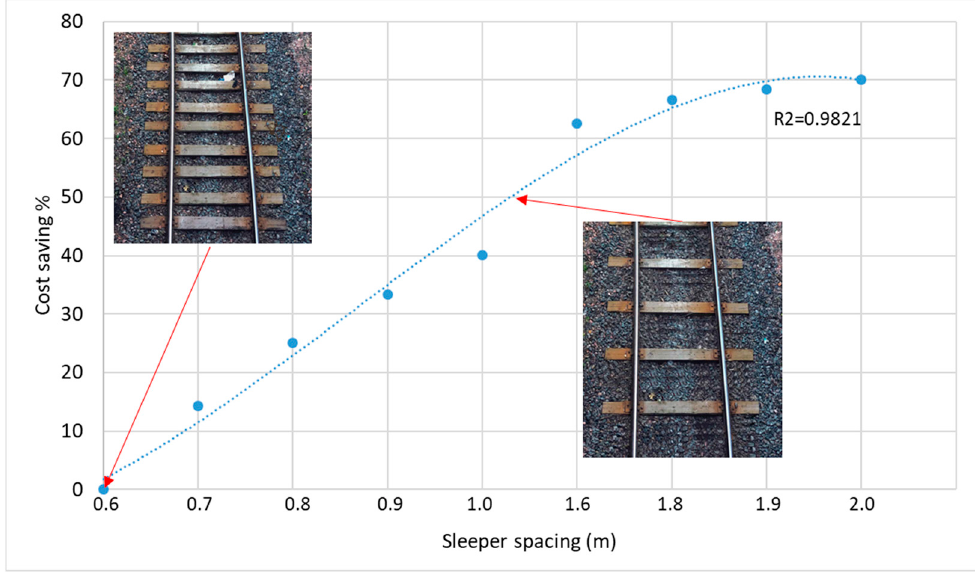
Figure 1. Cost savings estimation in terms of sleepers spacing.